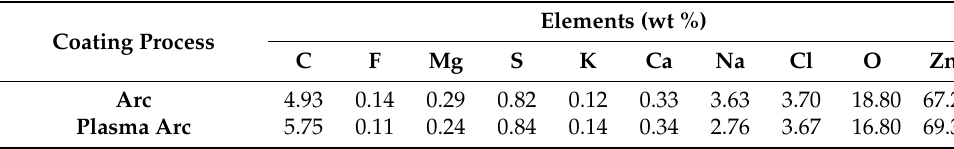
Table 6. EDS analysis of corrosion